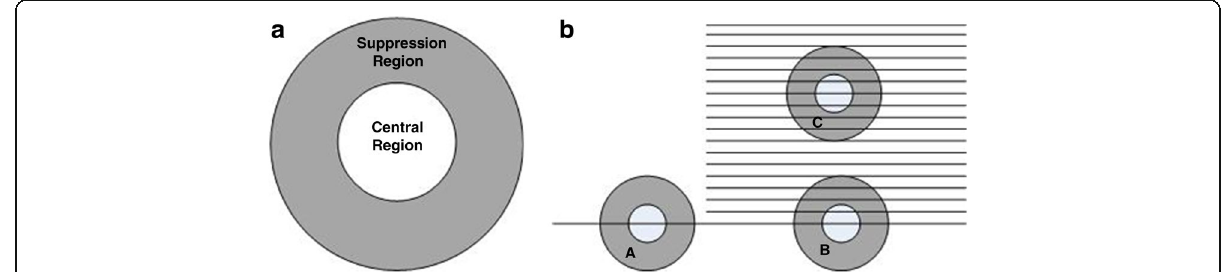
Fig. 1 Surround Suppression. a Model of surround suppression. b Suppression effects in different